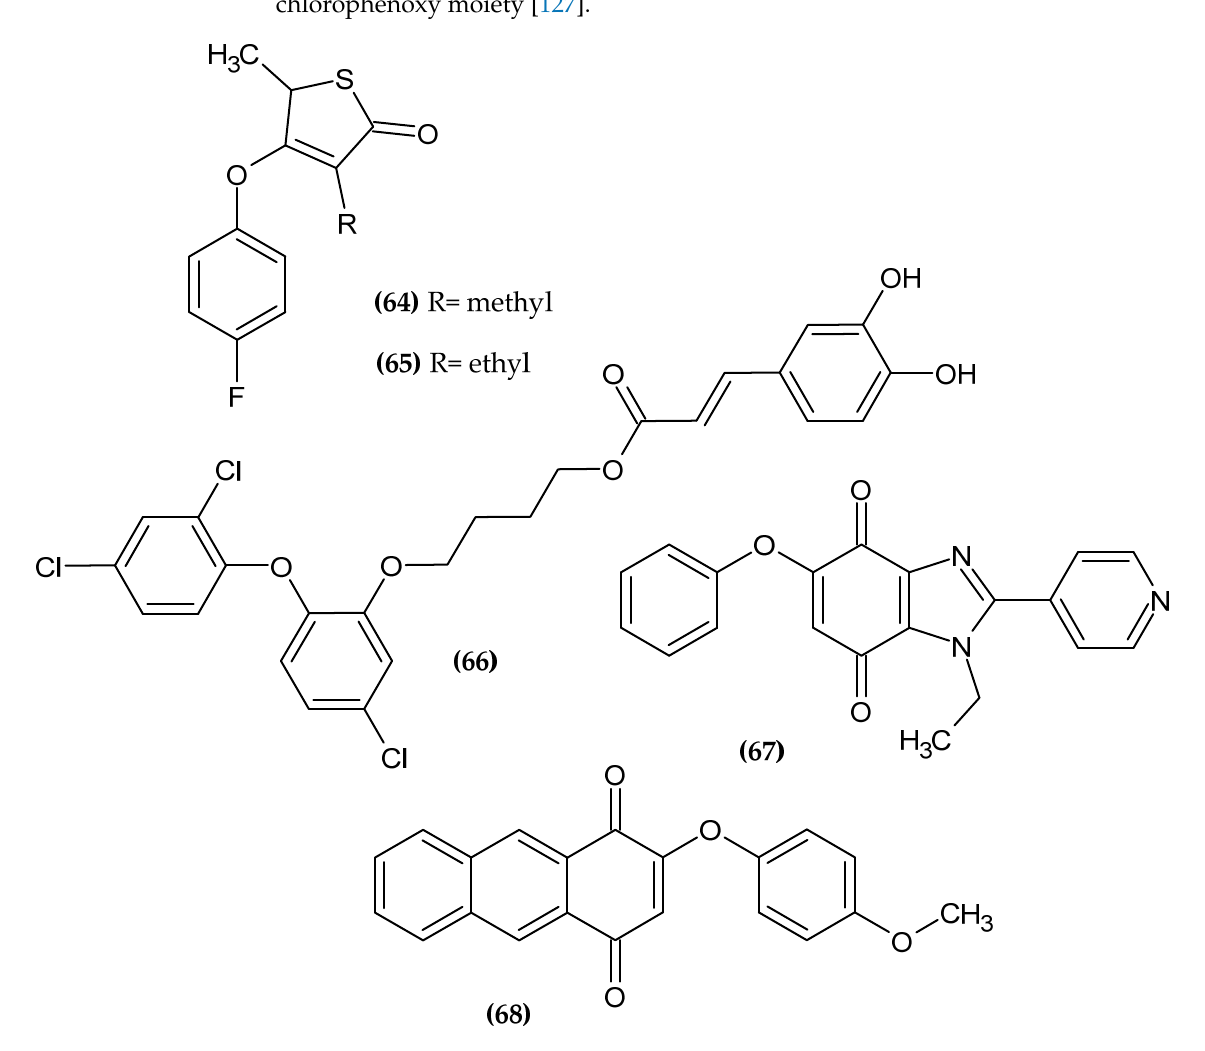
Figure 22. The novel potential agents with anti-parasitic activity bearing a phenoxy group.